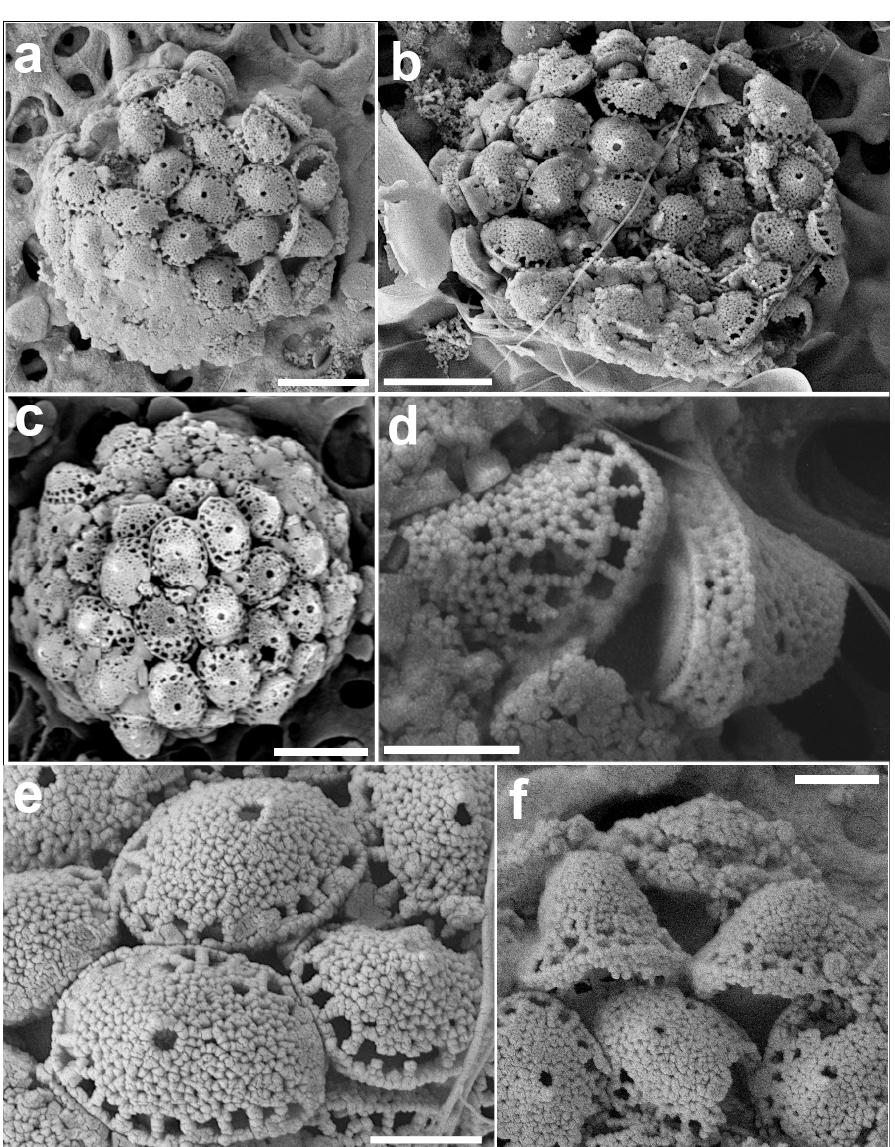
Figure 15. Calyptrosphaera lluisae . (a) Coccosphere with body coccoliths and a couple of putative circum-flagellar coccoliths at the bottom right of the image. (b) Coccospheres with BCs. (c) Specimen with mostly two rows of pores at the base of the distal cover; the scale bars in (a) – (c) are 3µm. (d) Coccoliths in side view with tube walls ca. four crystallites high. (e) Distal view of body coccoliths and (f) of circum-flagellar coccoliths with higher covers; scale bars: 1µm (all images from sample GoN, 14 June 2016, 1m).